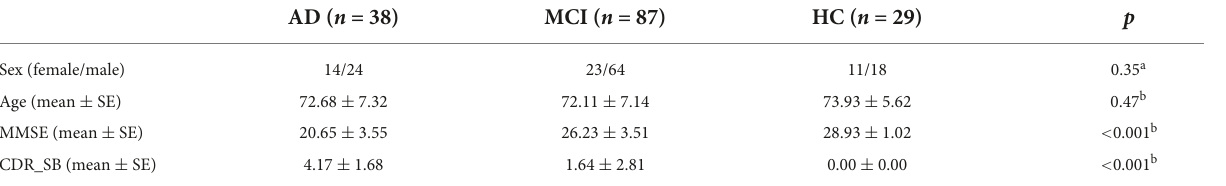
TABLE 1 Demographic and clinical information of participants.